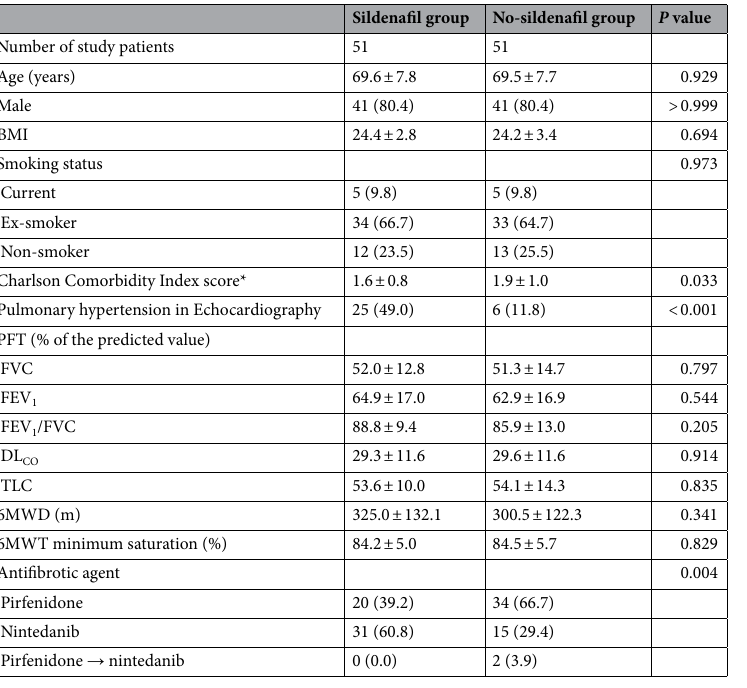
Table 1. Comparison of baseline characteristics between the sildenafil and no-sildenafil matched pair groups among patients with idiopathic pulmonary fibrosis. Data are presented as mean ± standard deviation or number (%). *Comorbidities in each group are described in Supplementary Table S2. BMI, body mass index; PFT, pulmonary function test; FVC, forced vital capacity; FEV 1 , forced expiratory volume in 1 s; DL CO , diffusing capacity of the lung for carbon monoxide; TLC, total lung capacity; 6MWD, 6-min walk distance; 6MWT, 6-min walk